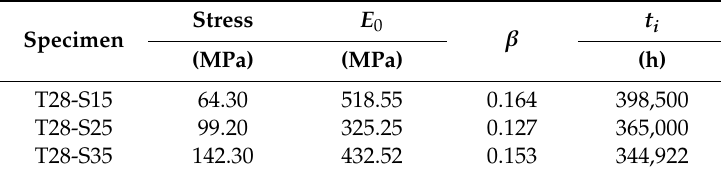
Table 4. Parameters to obtain the creep compliance by EPL expression.